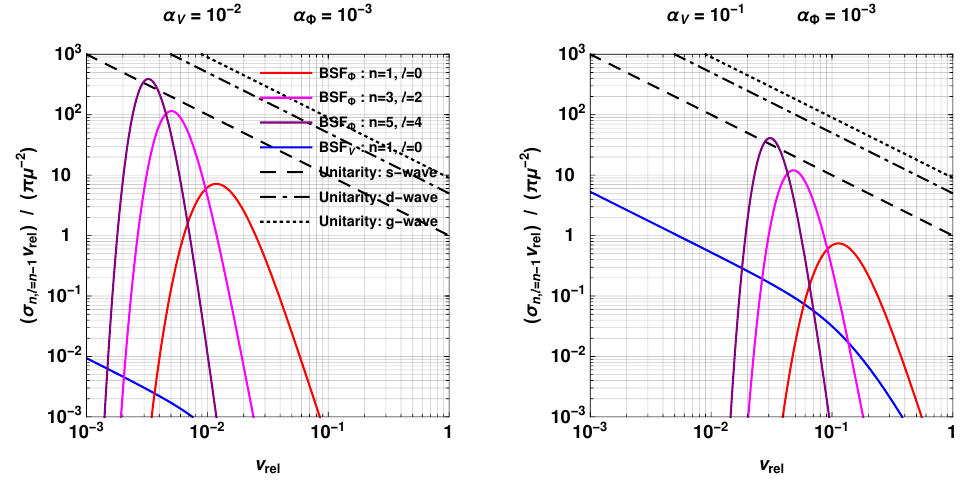
Figure 6 . Same as in (cid:12)gure 5, for capture into bound levels with ‘ = n (cid:0) 1, which have the highest multiplicity for a given n . We also show the respective unitarity limits for each process.